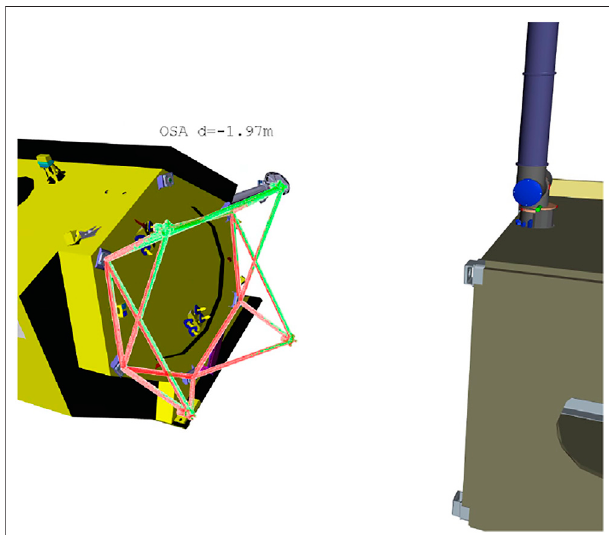
FIGURE 13 | Online grasp selection for spacecraft docking using the plain reachability map for the manipulator. On the client satellite structure (left) , green points show the kinematically feasible grasp locations, while red shows unfeasible locations for this particular relative pose between servicer and